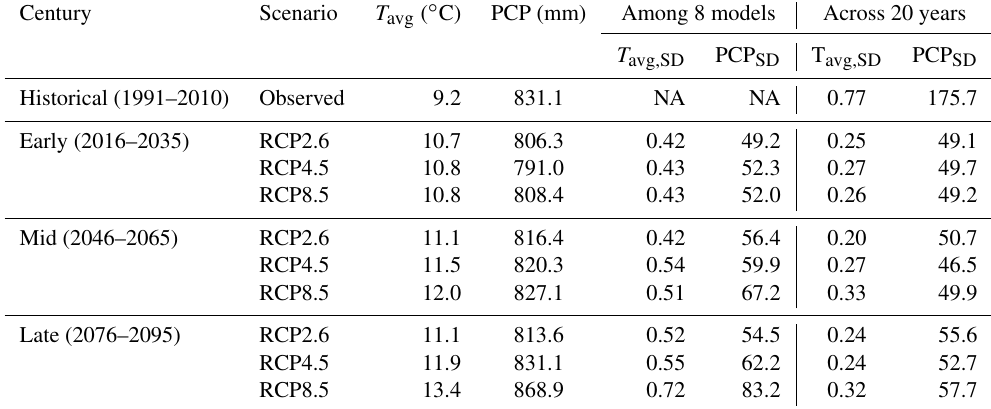
Table 5. Mean and standard deviations of average annual temperature and precipitation values for historical observed and ensembles of eight climate models used in this study ( T avg is annual average temperature, PCP is average annual precipitation T avg,SD is standard deviation of annual average temperature, PCP SD is standard deviation of average annual